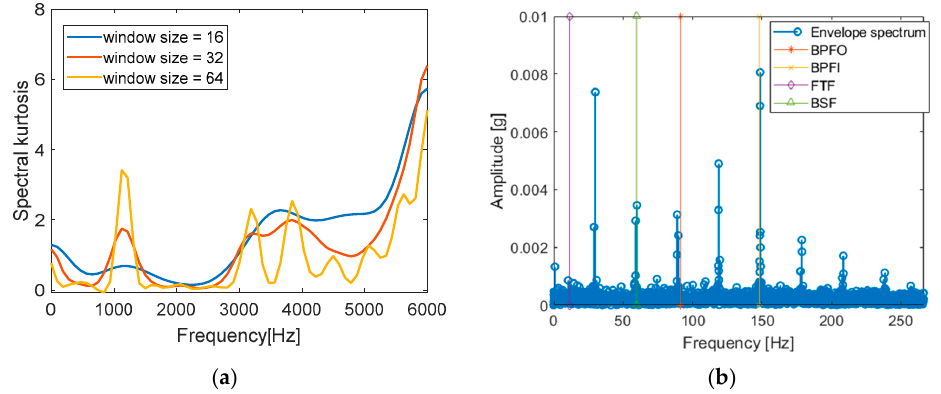
Figure 17. Results obtained from the code: CWRU bearing data (bearing280.mat) ( a ) Spectral kurtosis for bearing 270, and ( b ) Envelope spectrum after SK filtering.